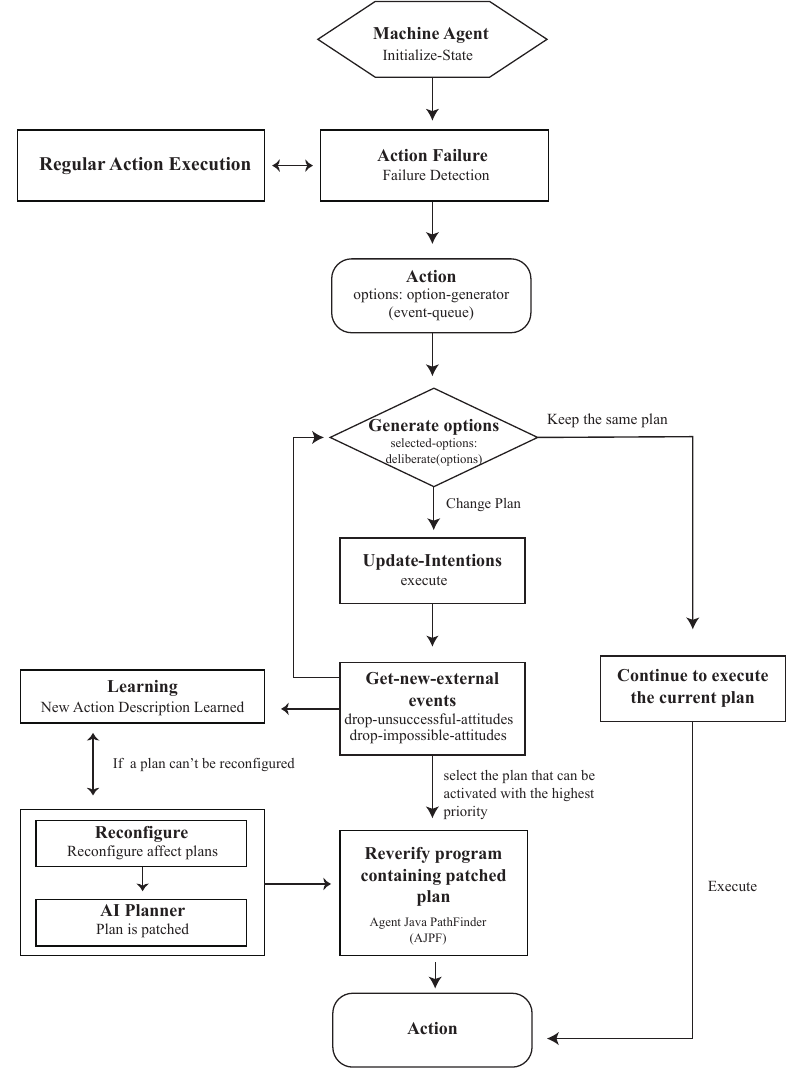
Figure 5. The concept of the communicate process in SENS+ smart sensor